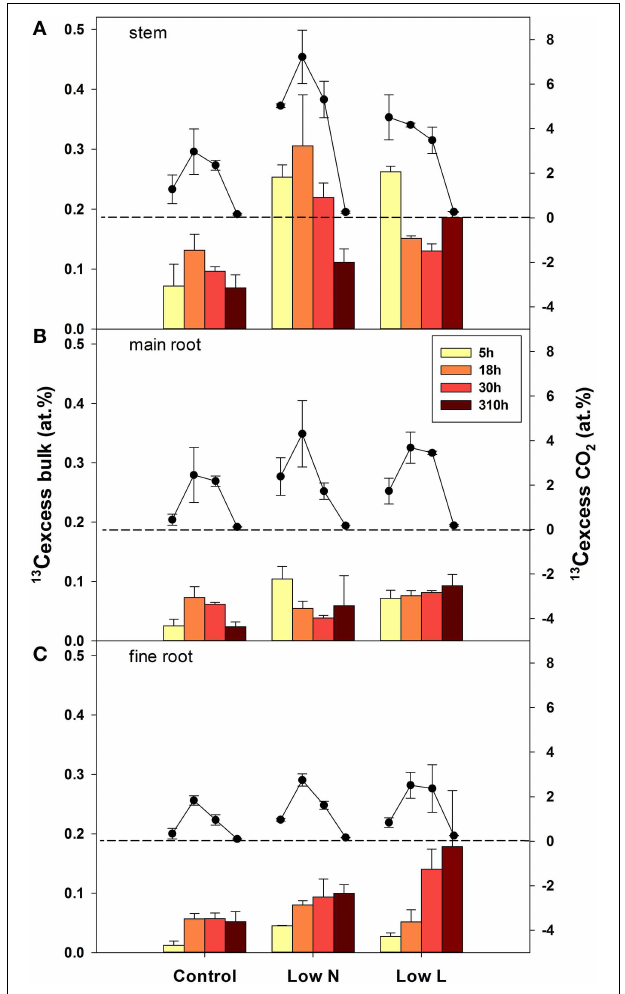
FIGURE 4 | Mean label derived 13 C ( 13 C excess ), in bulk material (bars, left y-axis) and respired CO 2 (circles, right y-axis) in stems (A), main roots (B), and fine root (C) over the four harvests during the chase period ( n = 2 ± SE). The broken lines indicate zero on the right